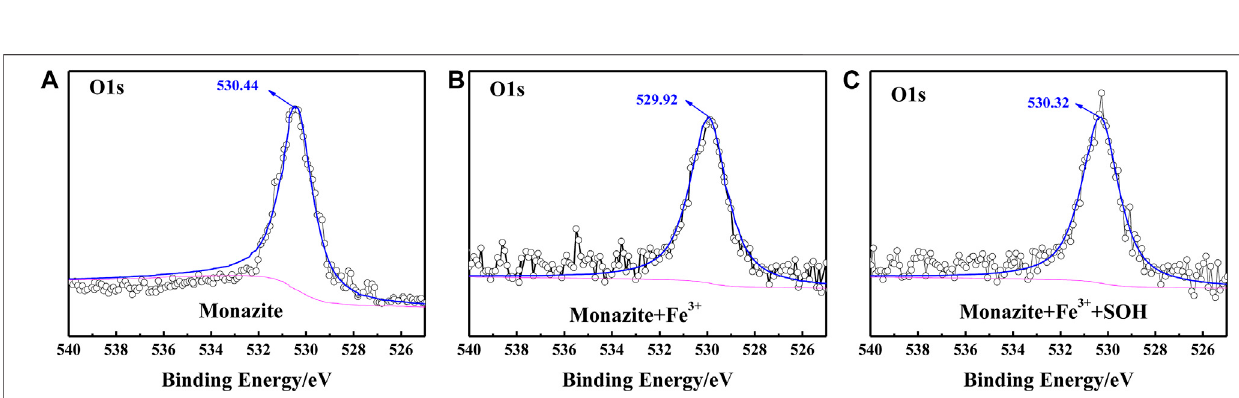
FIGURE 7 | Ce3d XPS spectrum on the (A) pure monazite surface, (B) monazite surface treated with Fe 3+ , and (C) monazite surface treated with Fe 3+ and SOH, respectively.